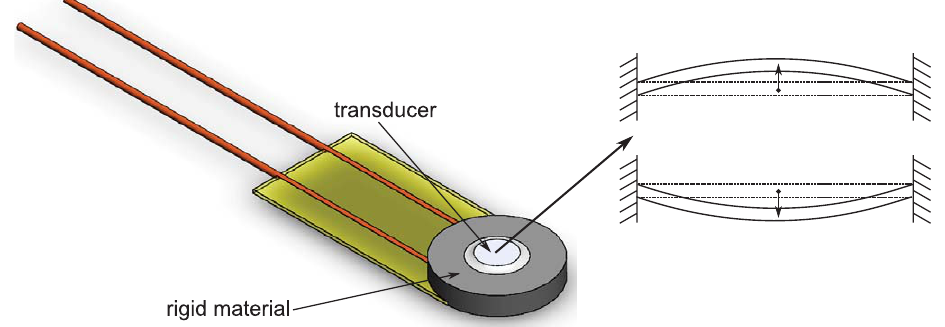
Fig. 5. Structure of the piezoelectric ceramic disk and vibration of the transducer.